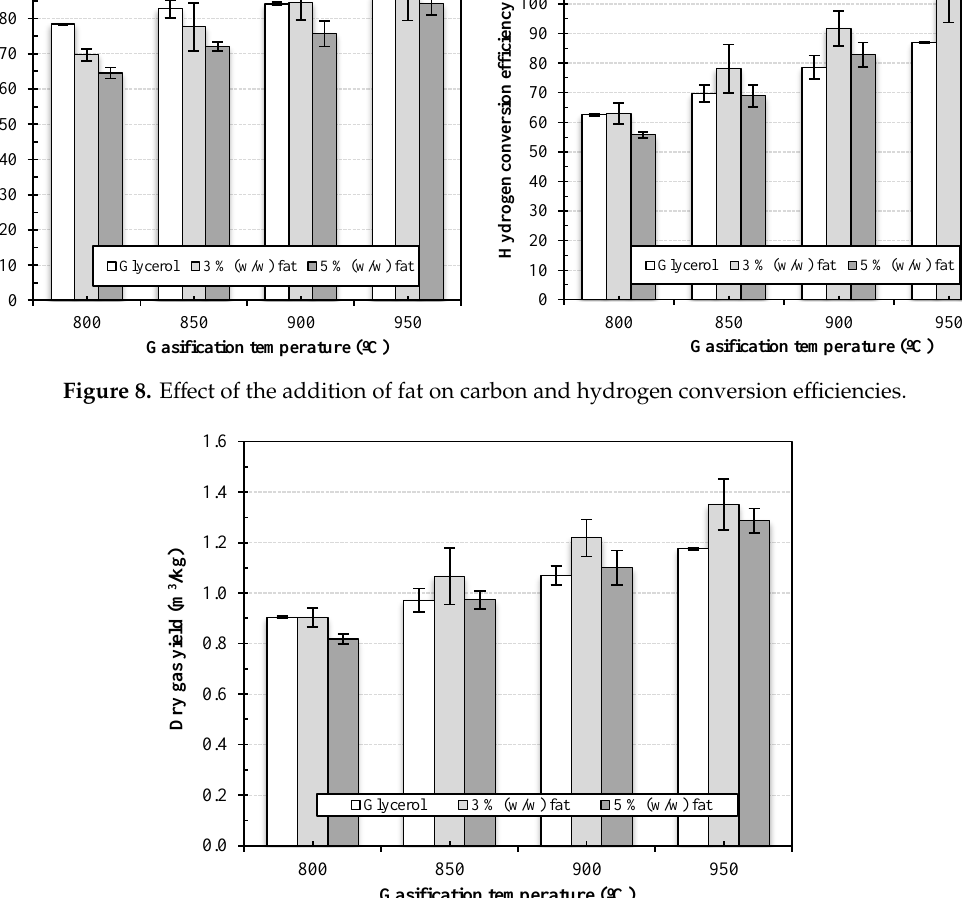
Figure 9. E ff ect of the addition of fat on dry gas Figure 9. Effect of the addition of fat on dry gas yield. Figure 8. Effect of the addition of fat on carbon and hydrogen conversion efficiencies.